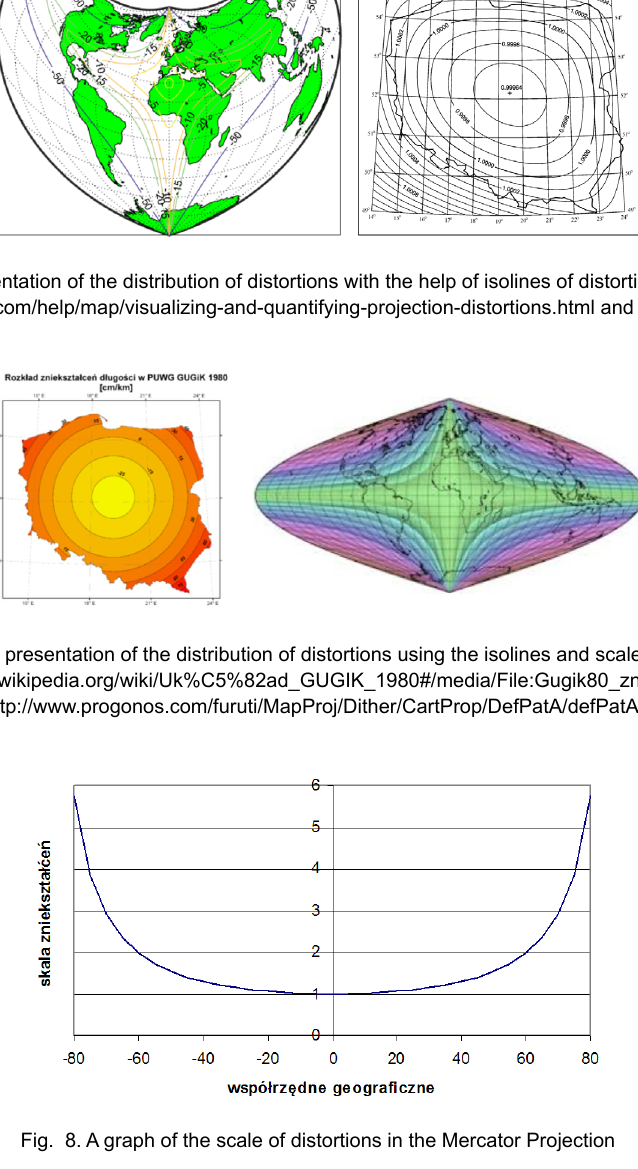
The graphs are often used for the presentation of distortions (fig. 8). If the distortions depend only on one variable, eg. the latitude, such a rep-